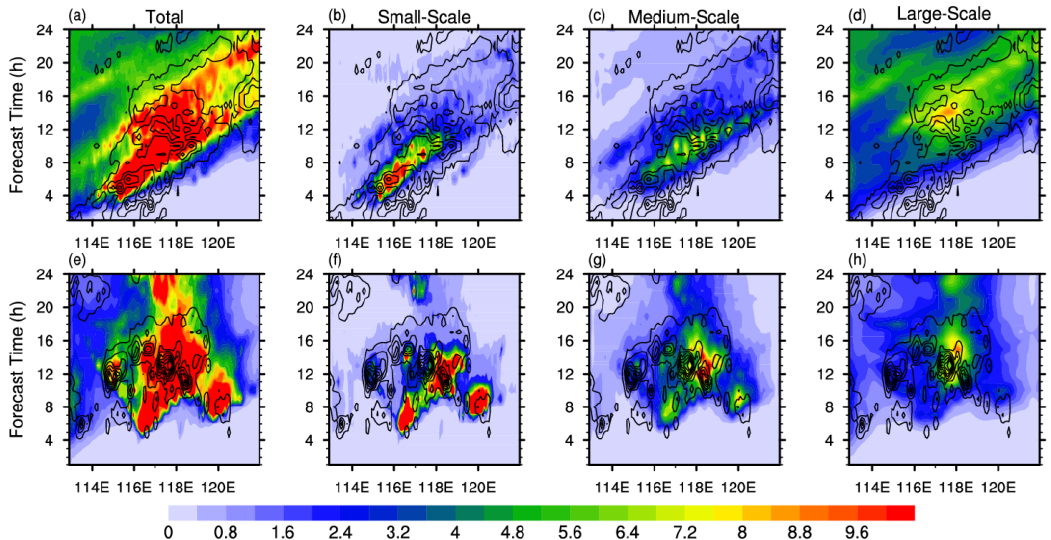
Figure 9. Hovmöller diagrams (time-longitude) of the RMDTE (shaded) and the precipitation (contour) at different scales in ( a – d ) the SF case and ( e – h ) the WF case.